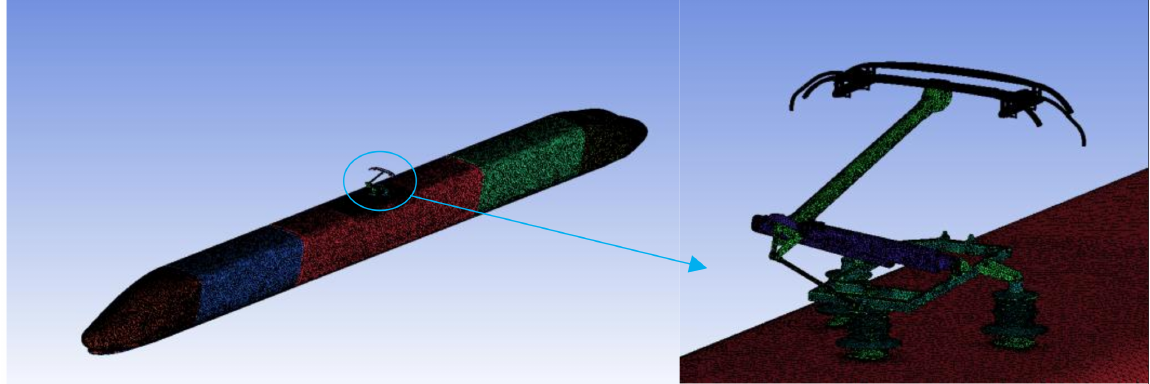
Figure 3. The aerodynamic models of the pantograph including the vehicle and locally enlarged